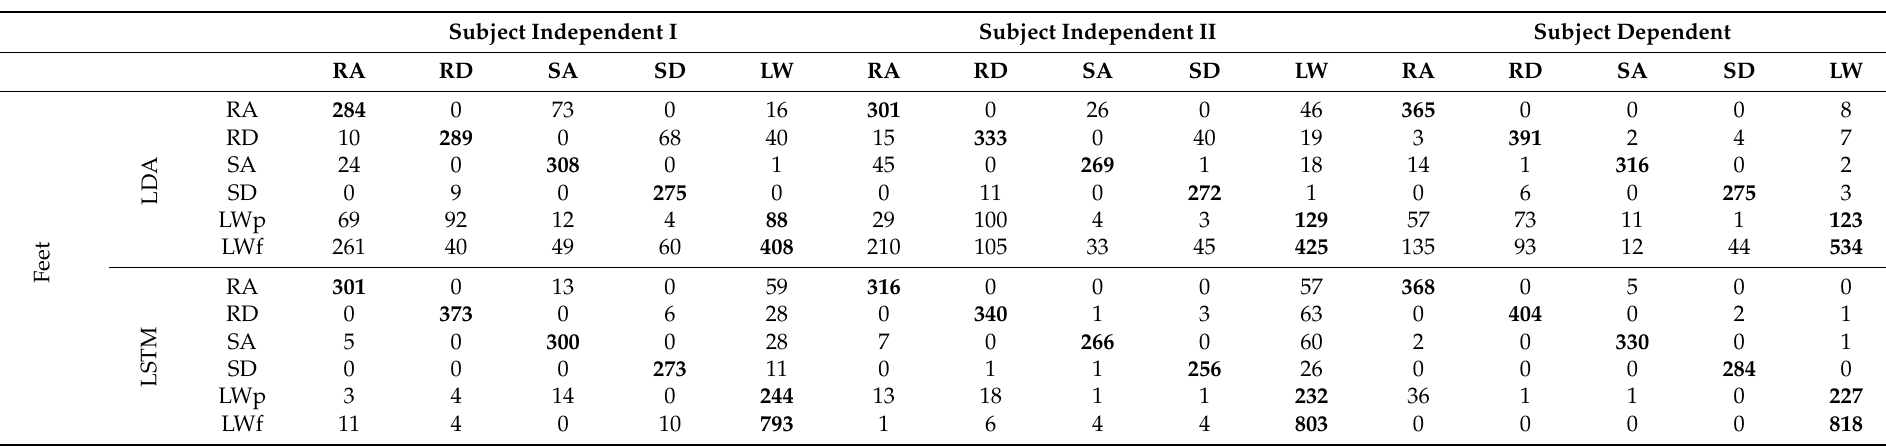
Table 2. Confusion matrices for classification of target locomotor tasks using signals from varying body segments and across different classification algorithms and training paradigms. The number of correctly classified windows for the target transitions are shown in bold. Non bold values are indicative of